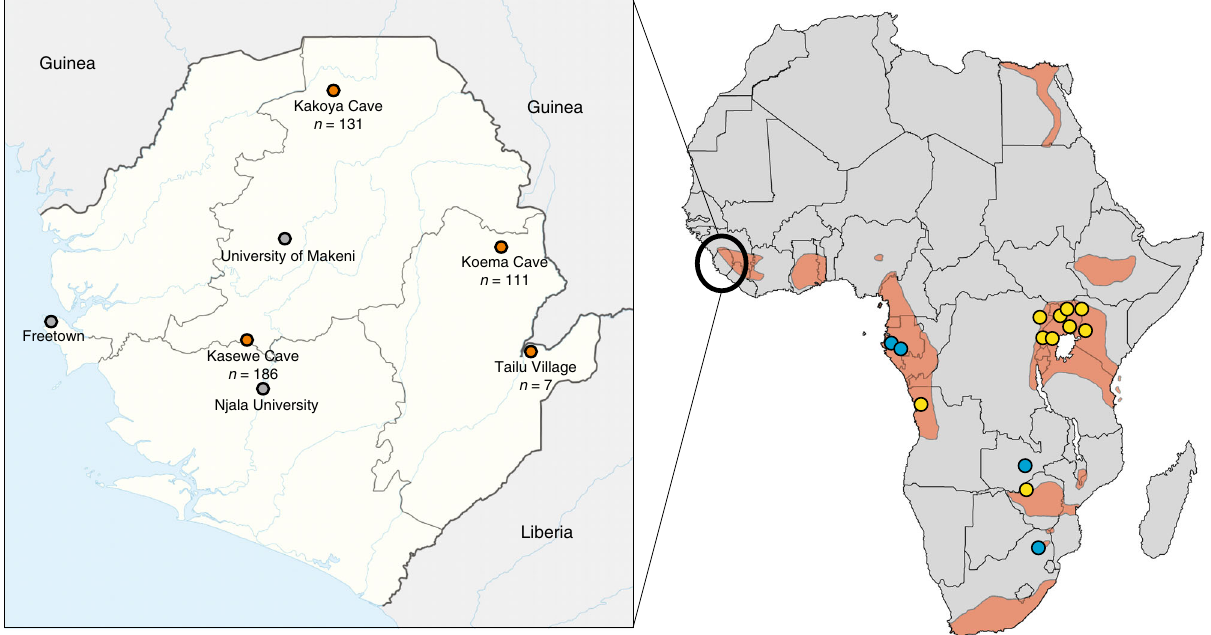
Fig. 1 Map of Sierra Leone showing bat trapping locations. Enlarged map shows locations of caves where populations of Marburg virus-(MARV) positive Egyptian rousette bats (ERBs; Rousettus aegyptiacus ) were discovered (orange circles). The numbers of ERBs captured at each site are shown below the cave name. Shown on the map of Africa are locations of MARV discovery in ERBs without an outbreak (blue circles), known MARV outbreaks (yellow circles), and the fragmented geographic range of the MARV natural reservoir, R. aegyptiacus (orange shaded). Image was adapted from base map provided by NordNordWest under Creative Commons Attribution-Share Alike 3.0 Germany license https://creativecommons.org/licenses/by-sa/3.0/de/